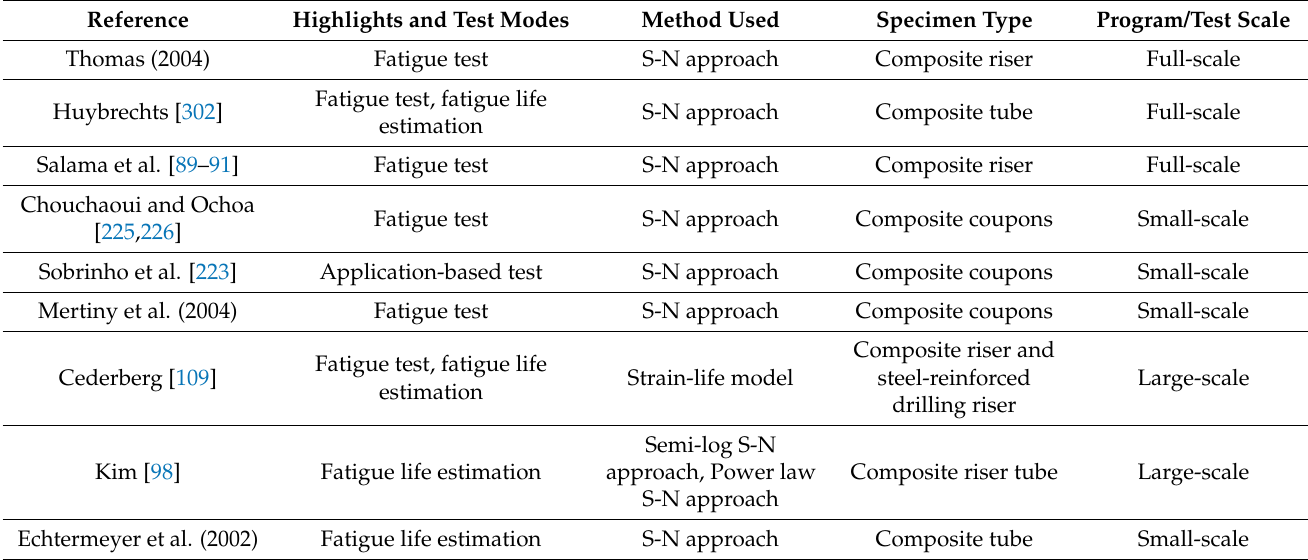
Table 8. Fatigue tests on composite risers with the scale of the